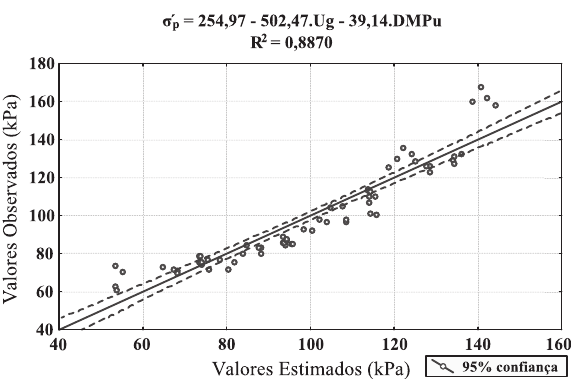
figura 4. modelo de tensão de pré-compactação ( s ´ p ) em função da umidade gravimétrica (ug) e do diâmetro médio ponderado dos agregados via úmida (dmpu). Valores estimados contra va- lores observados, na profundidade de 0–0,20